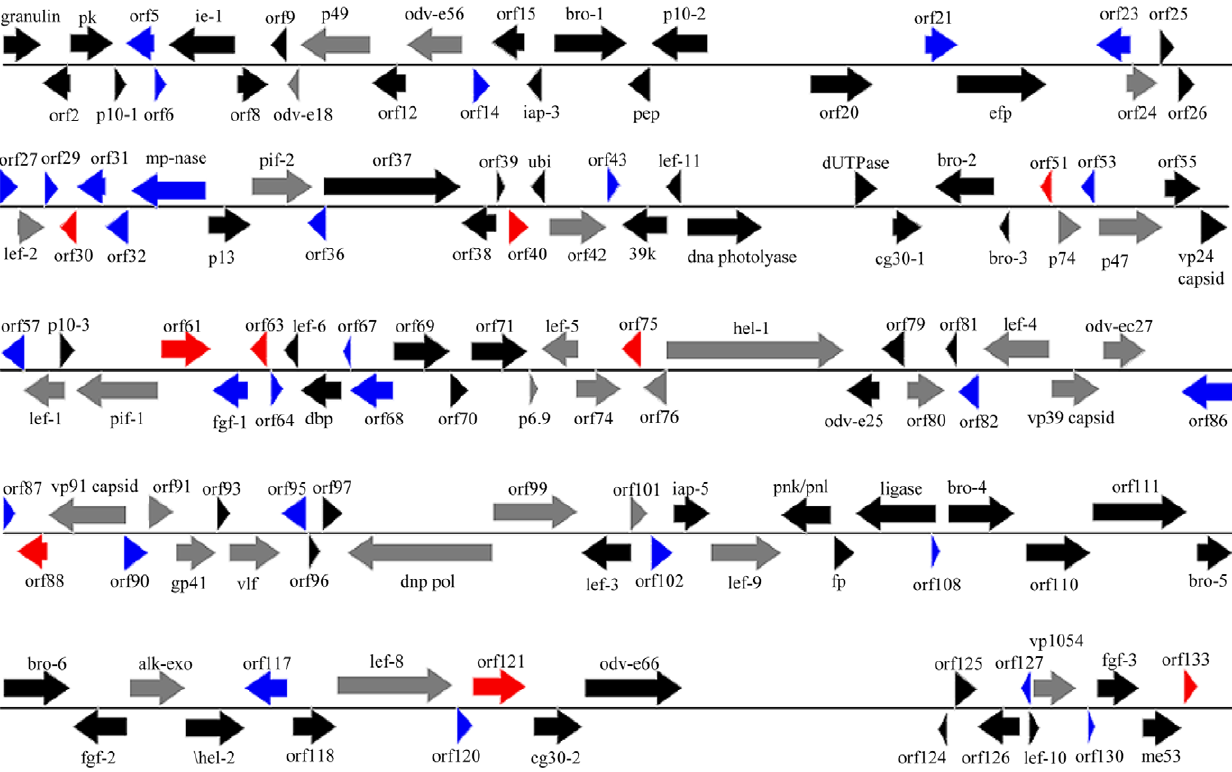
Figure 1. Representation of the SpliGV genome. ORFs and transcriptional direction are indicated by arrows. The ORFs present in most completely sequenced baculovirus genomes are colored gray; GV-specific ORFs are in blue; SpliGV unique ORFs are in red; and ORFs present in some NPVs and/or some GVs are in black.